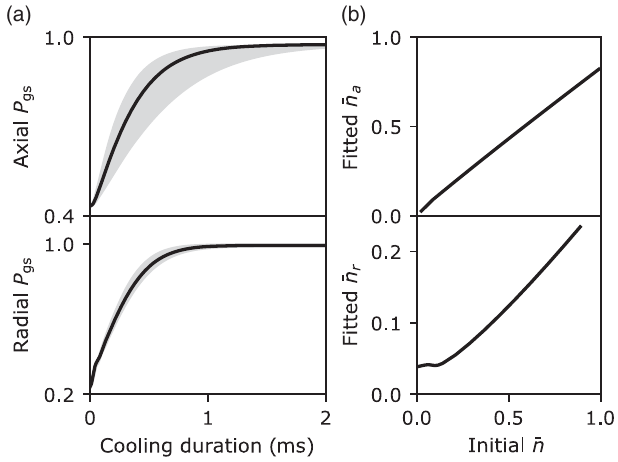
FIG. 7. Master-equation calculations. (a) Ground-state popu- lation ( P ) trajectory during cooling starting from upper bounds gs for the atom temperature after loading in the experiment. Simulations carried out in the axial (radial) direction for Rabi frequencies of 8.5 kHz (65 kHz) with a confidence interval of (cid:2) 2 . 5 kHz ( (cid:2) 10 kHz) denoted by gray region. (b) We simu- late the spectra for the axial and radial probing parameters for varying initial ¯ n ( x axis). We then fit the resulting simulated spectra identical to how we fit our data in order to extract the fitted ¯ n ( y axis). At low initial ¯ n , no further cooling is r 1 ;r 2 achieved given the probe parameters (i.e., the initial value is at or below the equilibrium value associated with the probe frequency being at the RSB